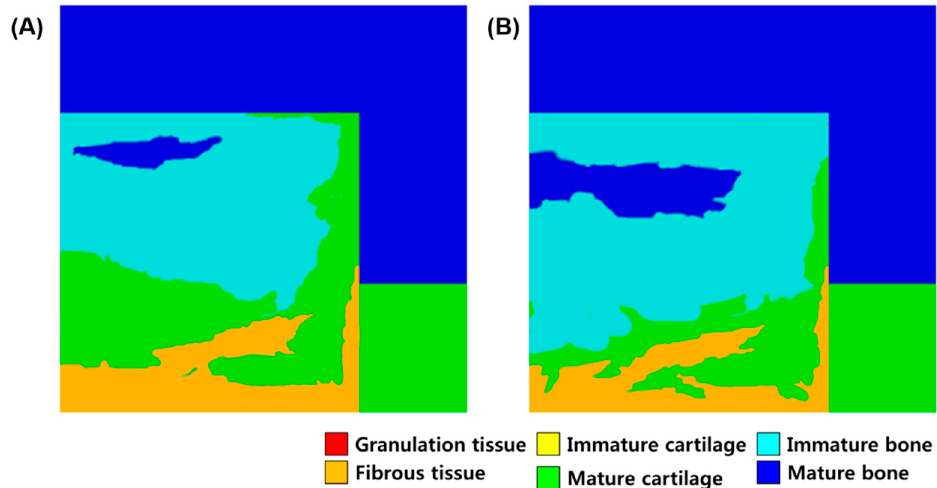
Figure 3. Predicted patterns of tissue differentiation with 5 mm cartilage defect in a simulation of ( a ) 25 iterations and ( b ) 50 iterations.